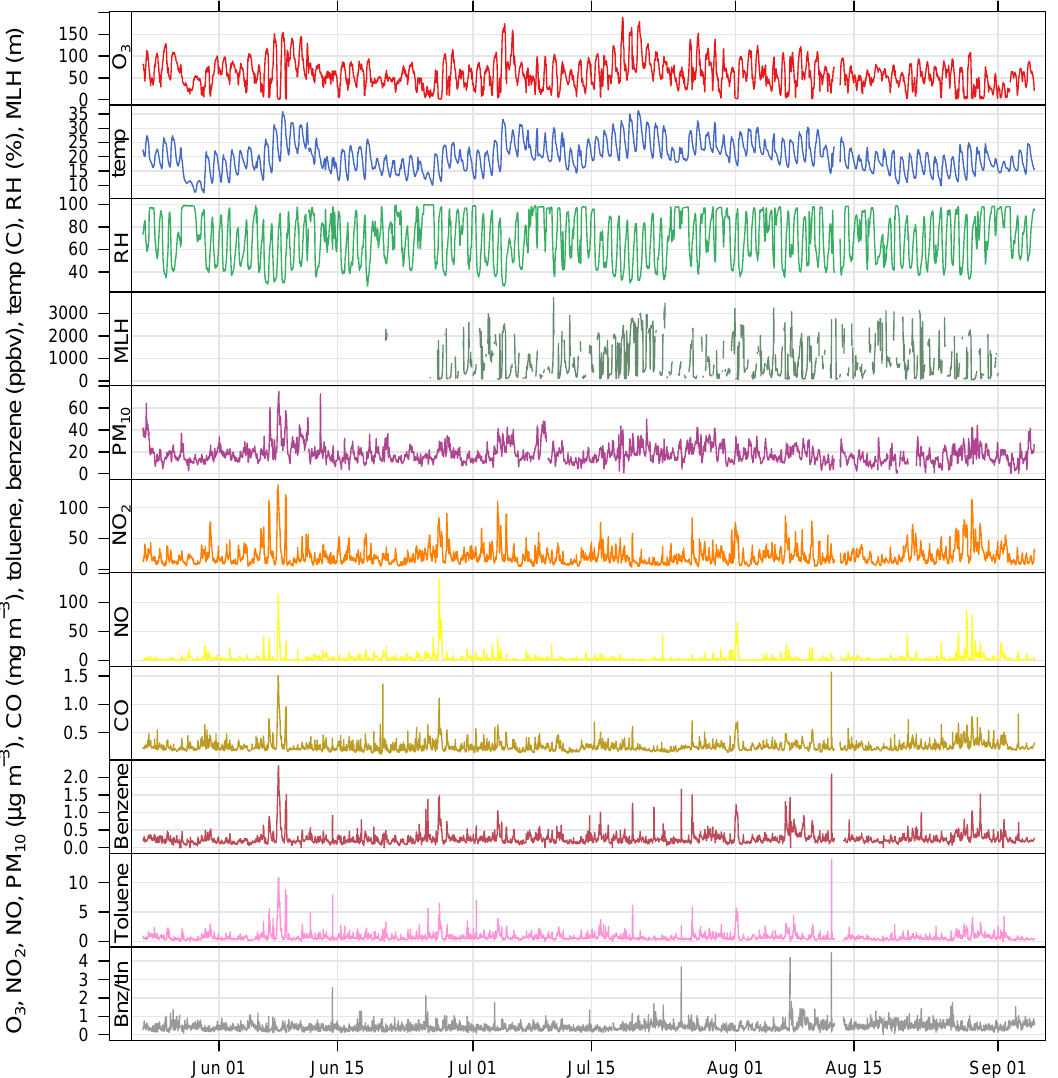
Figure 2. Time series of air pollutant concentrations, meteorological data, and benzene/toluene ratio measured as part of BLUME at the Neukölln station during the BAERLIN2014